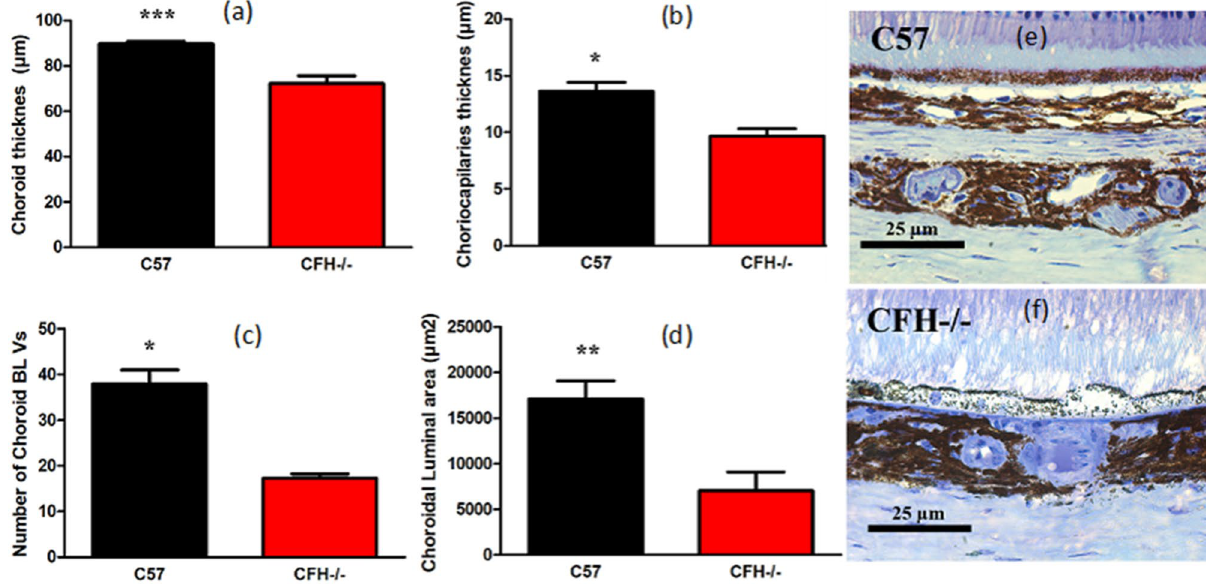
Figure 6. Measurements of choroidal integrity in C57 and CFH −/− mice at 6 months of age, produced using Adobe Photoshop Cs5 extended software, version 12.0. × 64. The choroid in CFH −/− mice (n = 4) is significantly reduced compared to the C57 (n = 4). This is true for total choroidal thickness ( a ), the thickness of individual choriocapillaris ( b ), the number of choroidal blood vessels ( c ) and the choroidal luminal area ( d ). ( e , f ) are respectively histological examples from C57 and CFH −/− mice. The choroid is the bottom just above the scale bar. The neural retina is to the top. Data are mean ± standard error (BL vs, Blood vessels, *p < 0.05, **p < 0.005, ***p <